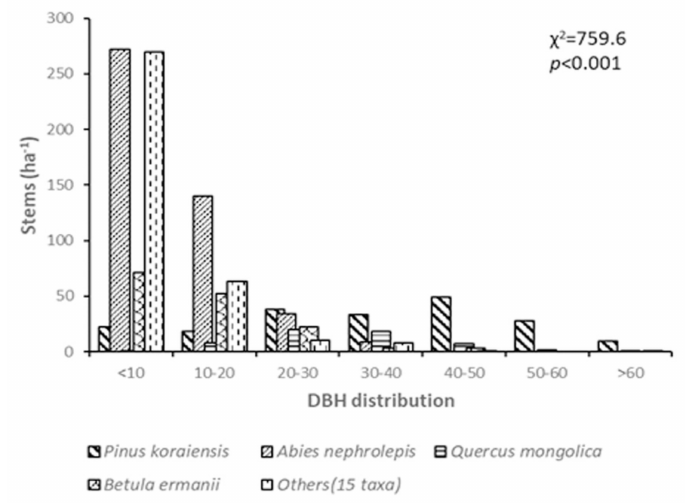
Figure 3. Woodys of diameter at breast height (DBH) distribution (data in